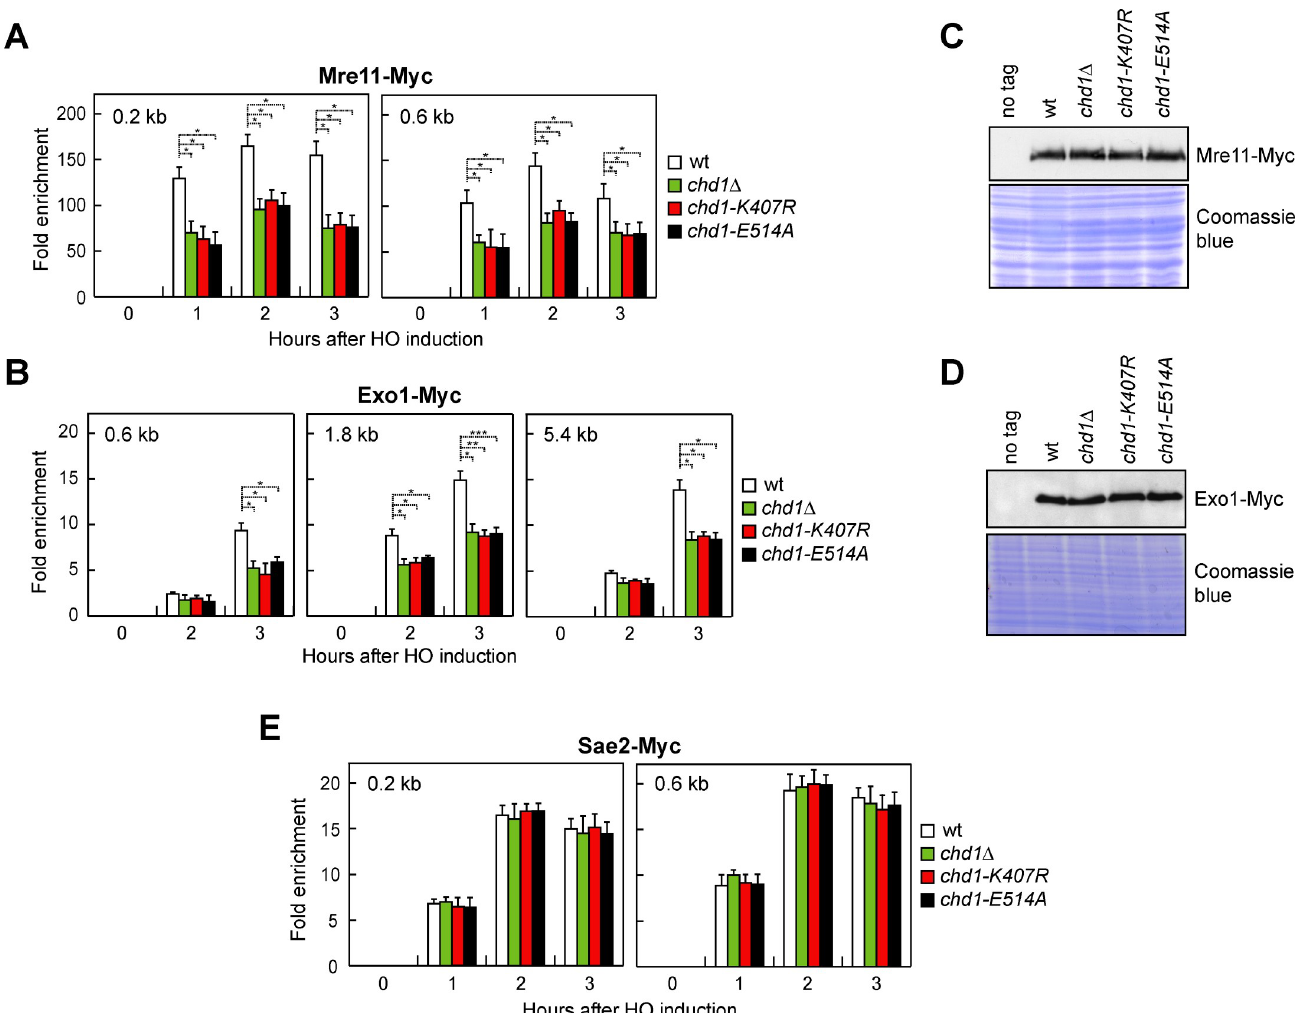
Fig 3. Chd1 dysfunction impairs MRX and Exo1 association with a DSB. (A,B) Mre11-Myc (A) and Exo1-Myc (B) ChIP at the indicated distances from the HO- cut site. Data are expressed as fold enrichment at the HO-cut site over that at a non-cleavable locus ( ARO1 ), after normalization to the corresponding input for each time point. Fold enrichment was normalized to cut efficiency. Plotted values are the mean values ± s.d. from three independent experiments. ��� P < 0.005, �� P < 0.01, � P < 0.05, t- test. (C,D) Western blot with anti-Myc antibodies of extracts used for the ChIP analysis shown in panels A and B. (E) Sae2-Myc ChIP at the indicated distances from the HO-cut